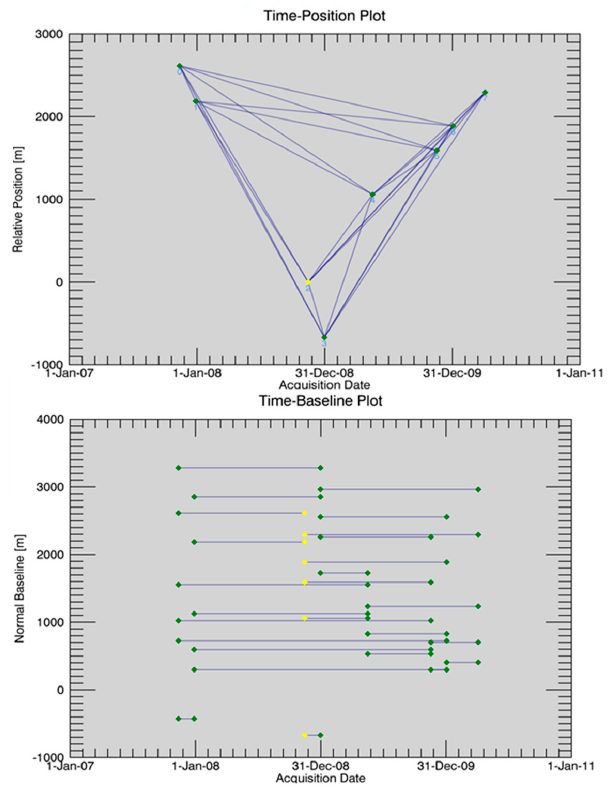
Figure 6. Plots show: time versus relative position ( top ); and time versus perpendicular baseline ( bottom ). Selected acquisitions are displayed as green points and the super master as yellow.